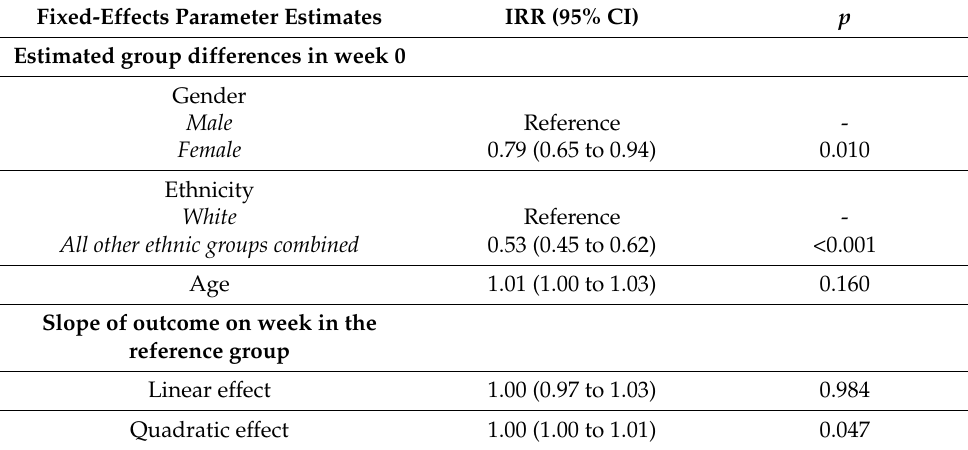
Table 2. Fixed-effects parameter estimates from the final trajectory model for steps walked per